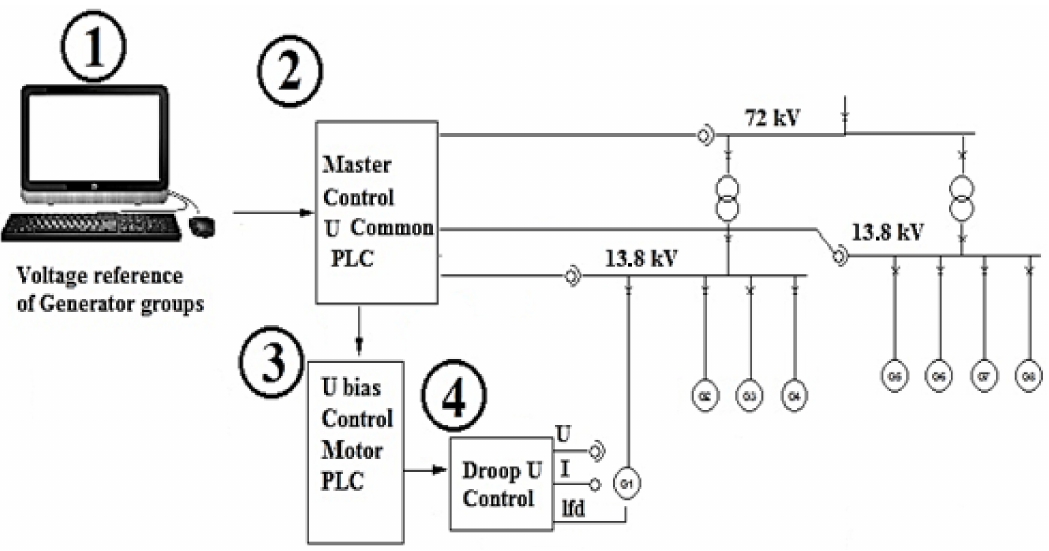
Figure 3. Specifications of the Automatic Voltage Regulator (AVR) Unitrol 1000 block diagram